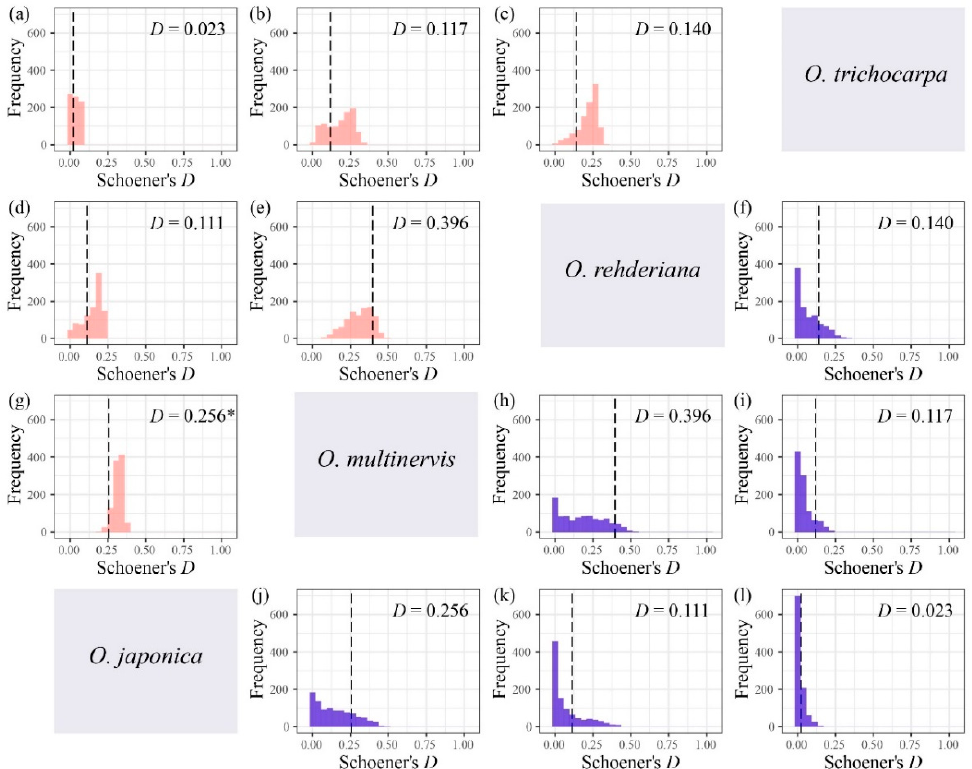
Figure 5. Niche overlap tests for four Ostrya species based on Schoener’s D , i.e., O. japonica vs. O. trichocarpa ( a ), O. multinervis vs. O. trichocarpa ( b ), O. rehderiana vs. O. trichocarpa ( c ), O. japonica vs. O. rehderiana ( d ), O. multinervis vs. O. rehderiana ( e ), and O. japonica vs. O. multinervis ( g ) using niche equivalency test; O. rehderiana vs. O. trichocarpa ( f ), O. multinervis vs. O. rehderiana ( h ), O. multinervis vs. O. trichocarpa ( i ), O. japonica vs. O. multinervis ( j ), O. japonica vs. O. rehderiana ( k ), and O. japonica vs. O. trichocarpa ( l ) using similarity test. Pink and blue represent equivalency and similarity tests, respectively. The Matric D assumed the niche overlap in microhabitat environments [87], ranging from 0 (no overlap) to 1 (complete overlap). The black dotted line represents the observed niche overlap between species pair (i.e., the empirical values of D ), whereas the histograms are those expected under the null hypotheses, and * represents that the niches are significantly ( p < 0.05) more different than expected by random.